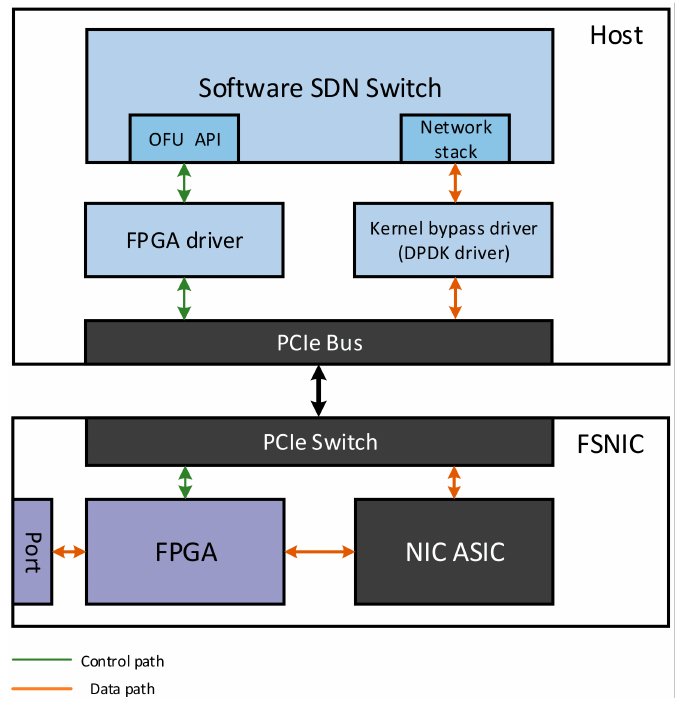
Figure 3. Overall architecture of our design.